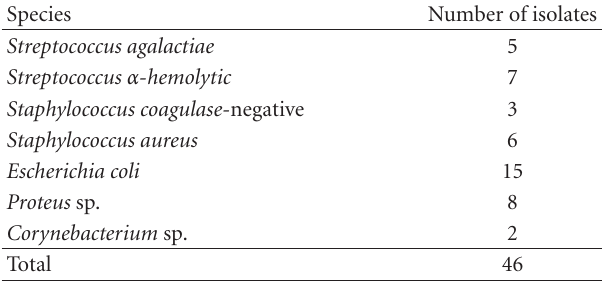
Table 1: Bacteria isolated from milk samples of mastitic cows.